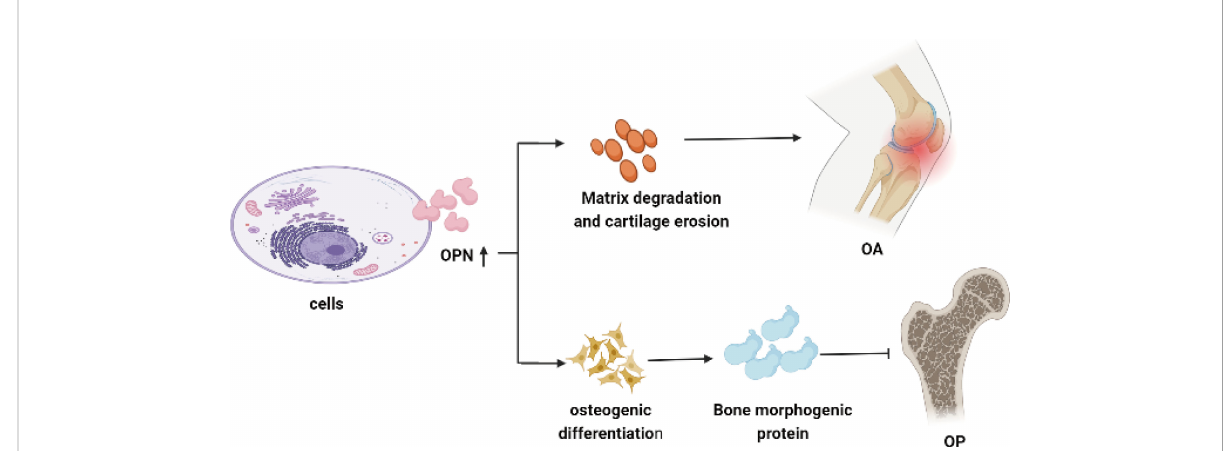
FIGURE 2 OPN involves in cartilage and bone metabolism in OA and OP. Overexpression of OPN enhances the proliferation of TRAP-positive osteoclasts and secretion of matrix metalloproteinase, leading to bone erosion and cartilage degeneration in OA. High levels of OPN could increase matrix deposition and enhance bone remodeling by promoting osteoblasts differentiation along with the elevated level of bone morphogenetic proteins, resulting in reducing the pathological changes of